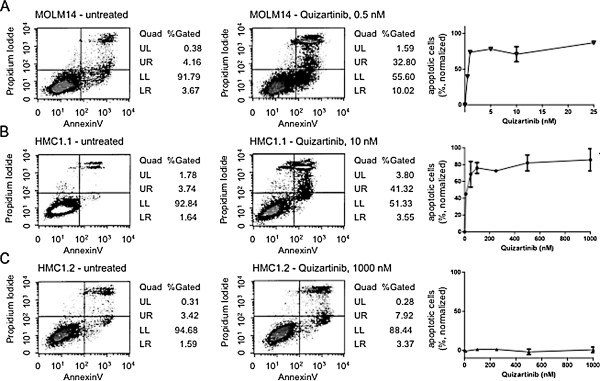
Quizartinib potently induces apoptosis in selected leukemia cell line models. Leukemia cell lines harboring FLT3, KIT or PDGFRA mutations were treated with various doses of quizartinib for 48 hours and induction of apoptosis was measured using an annexin V-based assay. Representative density plots indicating early phase apoptosis (annexin V-positive cells) or late phase apoptotic cells (propidium iodide positivity) fractions are shown in a quadrant density dot plot. Whereas the FLT3 ITD + cell line MOLM14 (A) and the mutant-KIT V560G + cell line HMC1.1 (B) reveal potent sensitivity in the lower nanomolar range, the sister cell line HMC1.2 (C), harboring an additional KIT D816V mutation, is insensitive towards quizartinib treatment. Data presented in the dose–response curves on the right represents the average mean of at least 3 separate experiments (each normalized to the untreated controls, which are set to zero). IC50s of all tested cell lines are provided in Table 2.